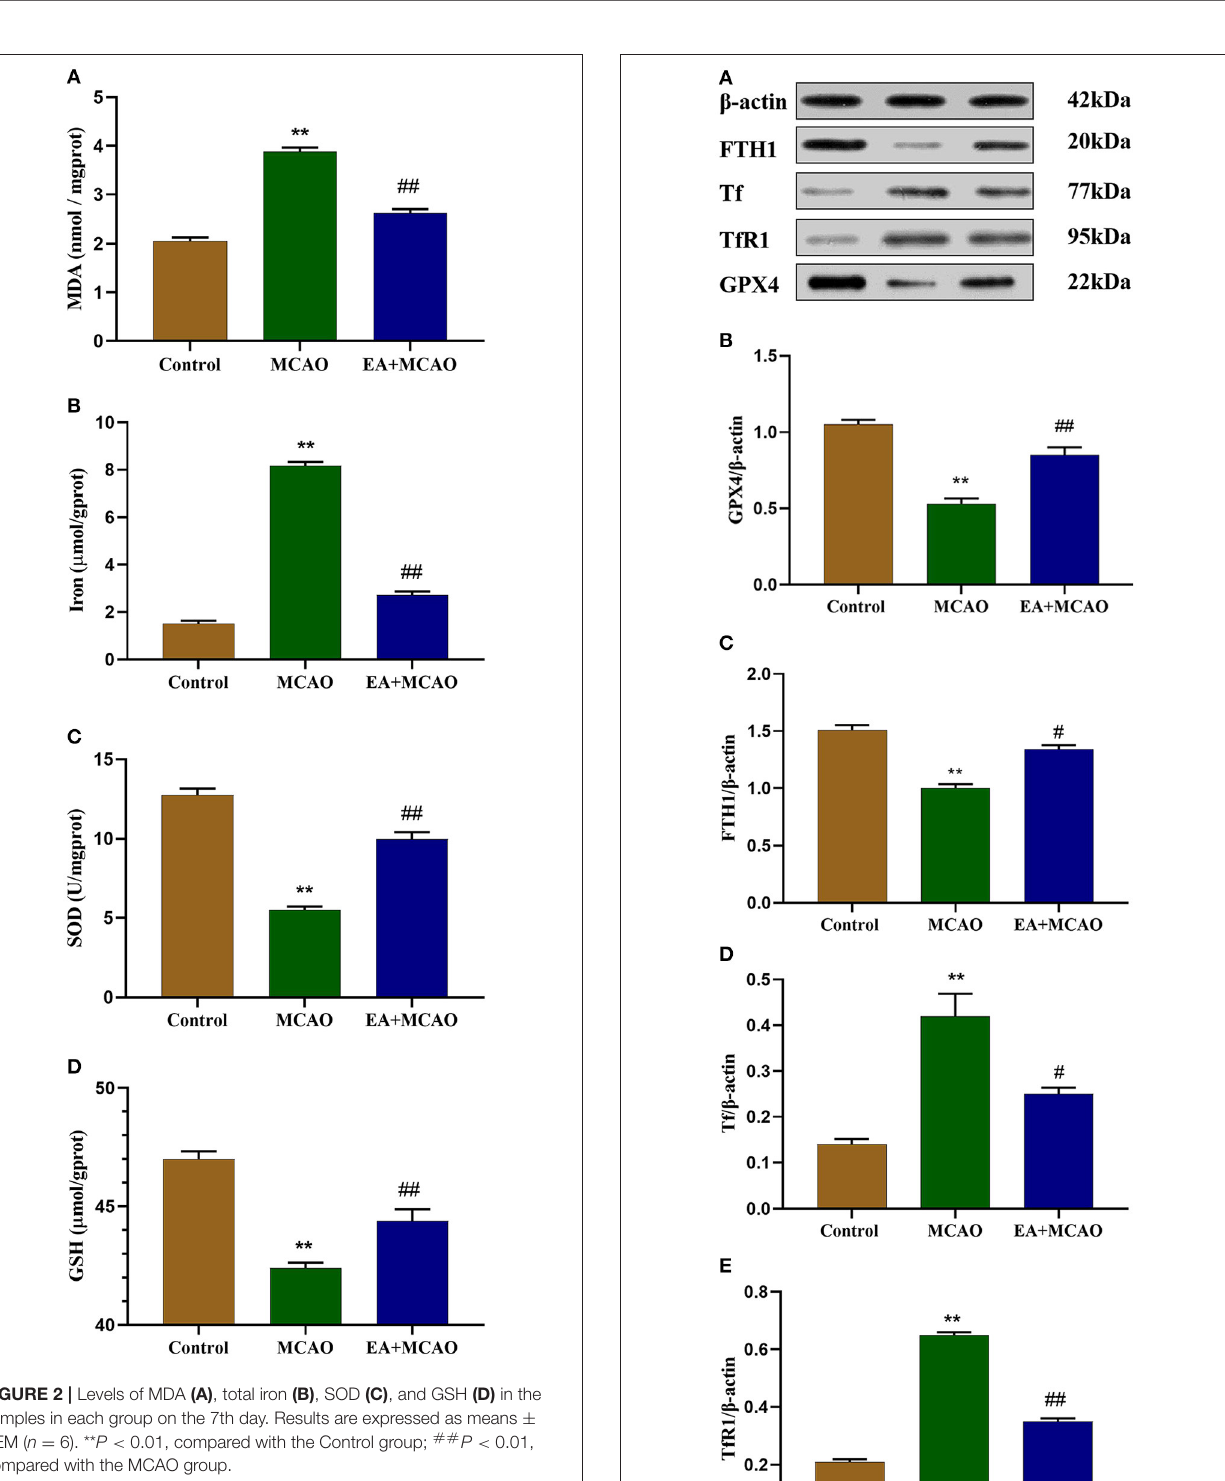
( Figure 3A ). As shown in Figures 3B,C , the levels of GPX4 and FTH1 were significantly decreased in the MCAO group compared with those in the Control group ( P < 0.01 and P < 0.01, respectively); however, EA intervention reversed this change in the EA + MCAO group ( P < 0.01 and P < 0.05,